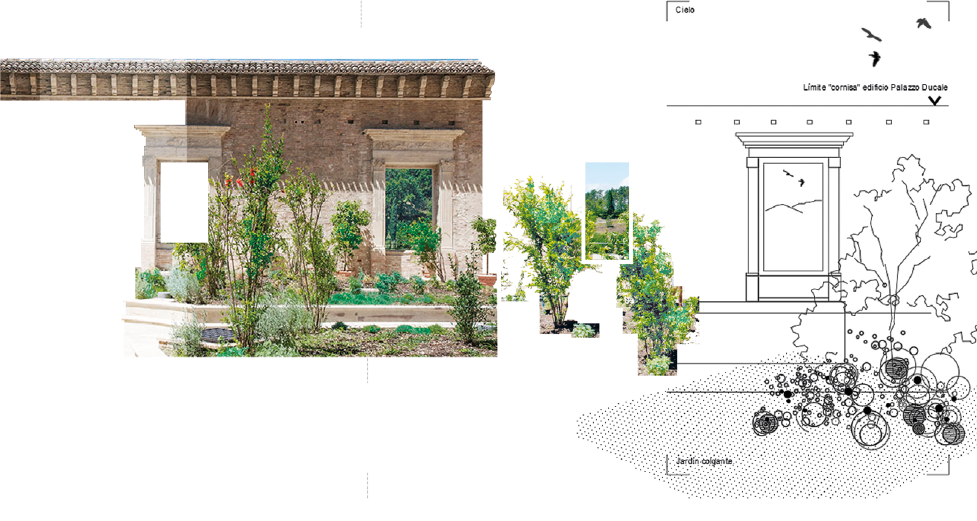
Hanging gardens and land- scape frames on the “magic wall” of Urbino. Photograph of the “ Giardino Pensile ” trapezoi- dal of the Palazzo Ducale of Urbino. Source: Collage-draw- ing by the author.